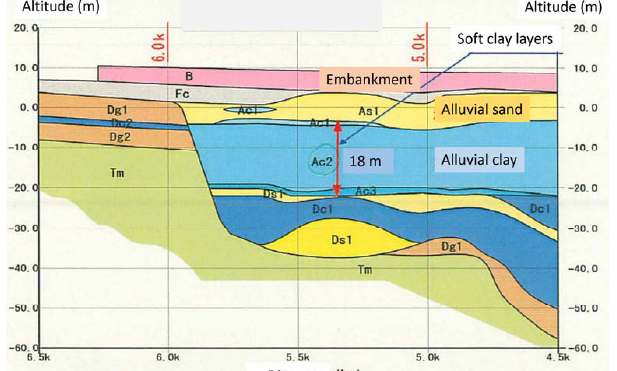
Figure 3. Void ratio vs. consolidation pressure relations for predic- tion of post-earthquake settlement of clay deposits (from Kazama, 2014).